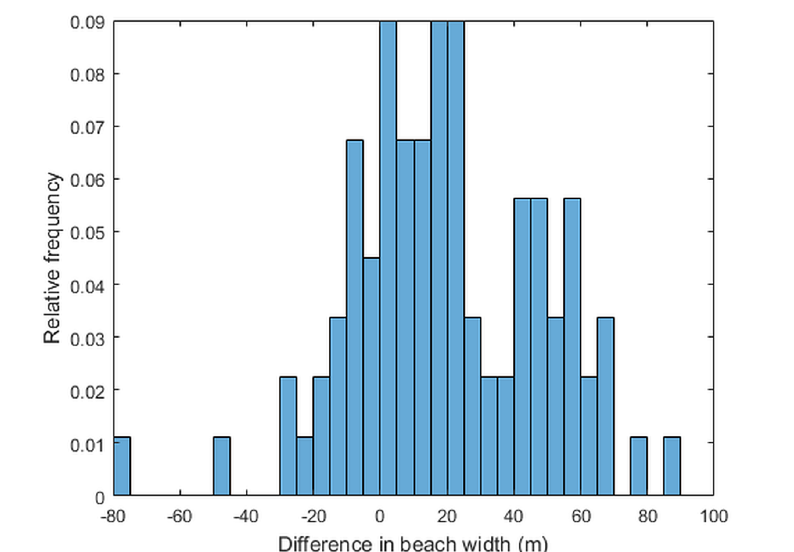
Figure 9. The difference in beach width during the part of the day with limited and unlimited transport. A positive difference implies a larger width during unlimited transport than during limited